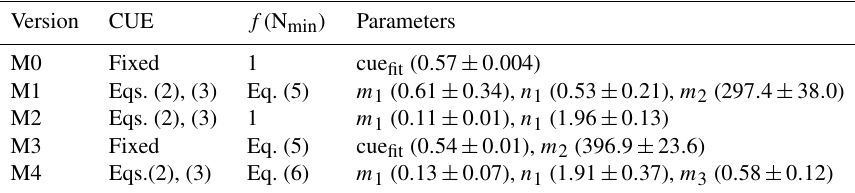
Table 1. Optimized parameter values for the five versions of the litter decomposition model used in this study. cue fit is the optimized value of CUE, m 1 and n 1 are the coefficients in Eq. (3), m 2 is the coefficient in Eq. (5), and m 3 is the coefficient in Eq. (6). Values in brackets following each parameter are the means ( ± standard deviations) of the fitted parameter values based on “leave-one-out” cross-validation (see Sect. 2.5 for more